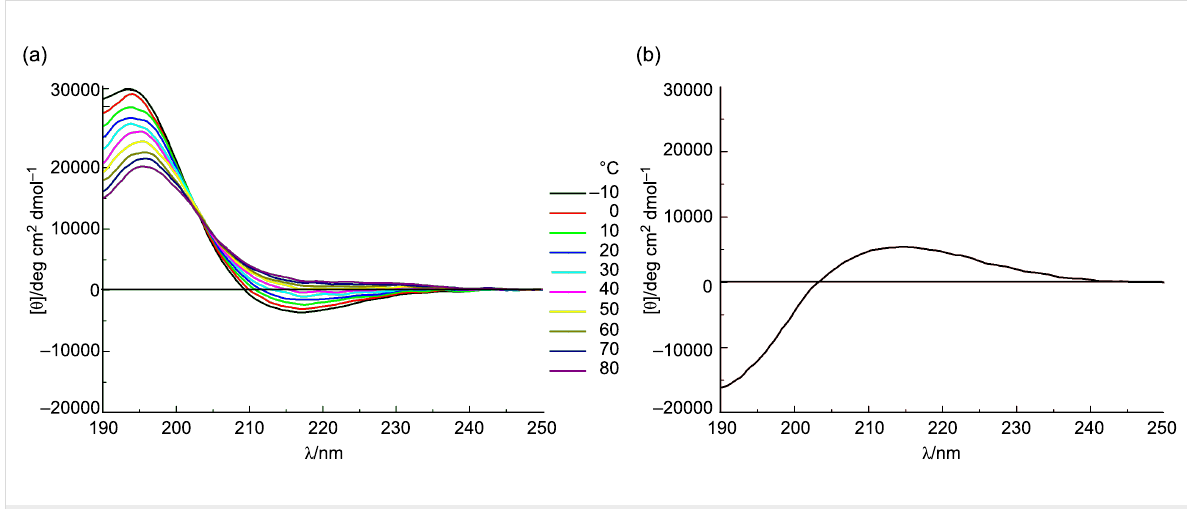
Figure 4: (a) Temperature-dependent CD spectra of the glycosylated D-Thr and D-Ala containing peptide 7 from − 10 to 80 °C in water, revealing an isodichroic point at 203 nm; and (b) the difference spectra between +80 and − 10 °C.